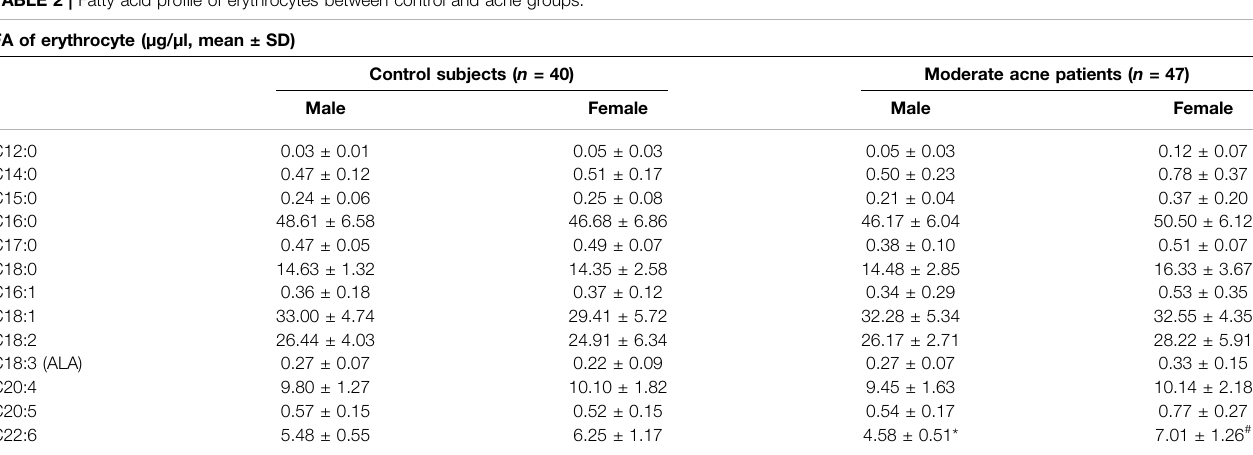
TABLE 2 | Fatty acid pro fi le of erythrocytes between control and acne groups. FA of erythrocyte ( μ g/ μ l, mean ± SD) Control subjects ( n = 40) Moderate acne patients ( n =